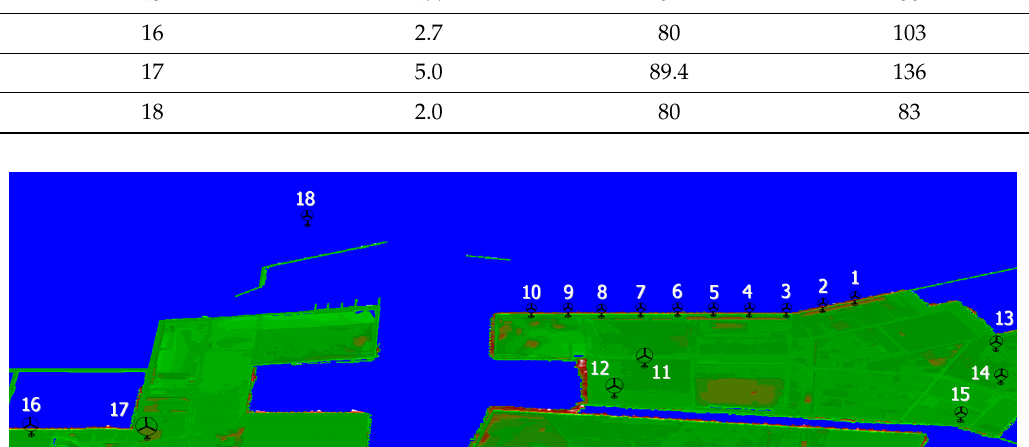
Figure A3. LES using the CFD PD wake model for multiple wind turbines. The blue area indicates the sea.